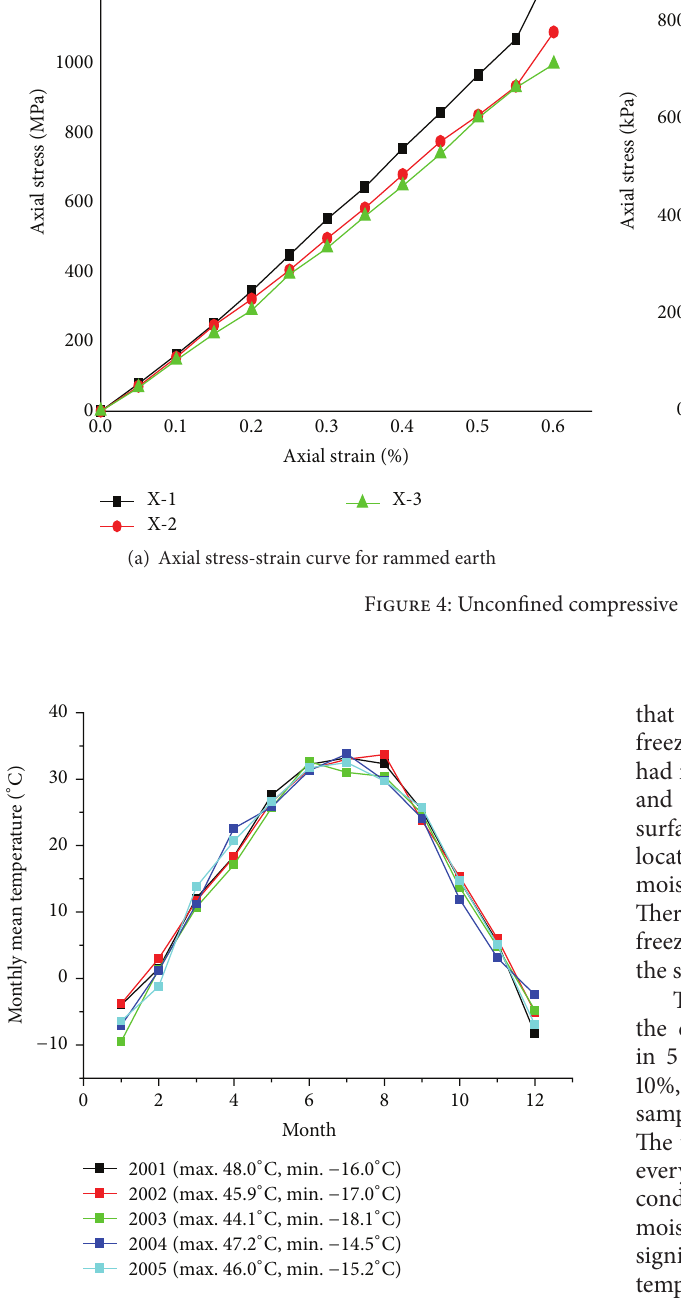
Figure 5: Meteorological data in 2001 ∼ 2005 years in Turpan region.